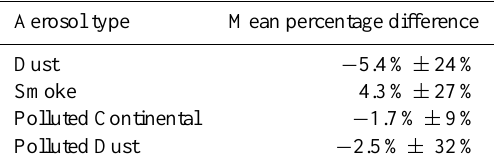
Table 7. Mean percentage lidar ratio difference between the S AC calculation and the CALIOP modeled value S CALIOP , 532 for the single best matching 5km horizontal resolution